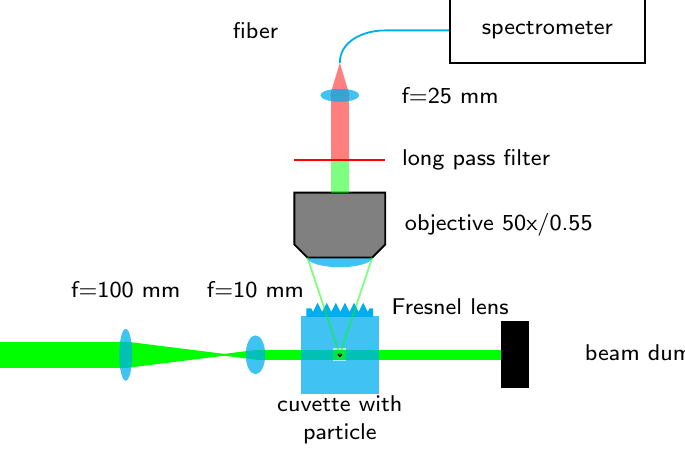
Figure 1. Arrangement to measure the Raman scattering.